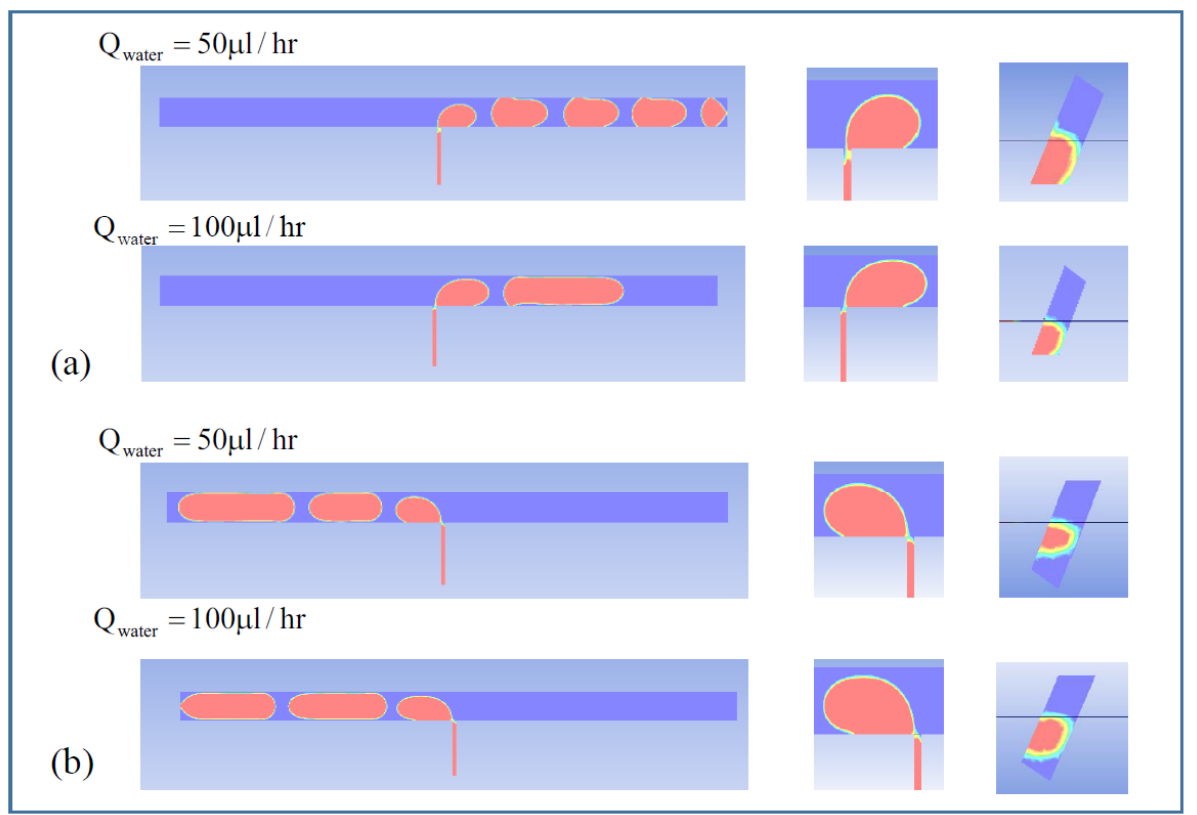
Figure 8. Void fraction of micro-droplet phase in the channel of W12-A45-B54. ( a ) A → B direction, ( b ) B → A